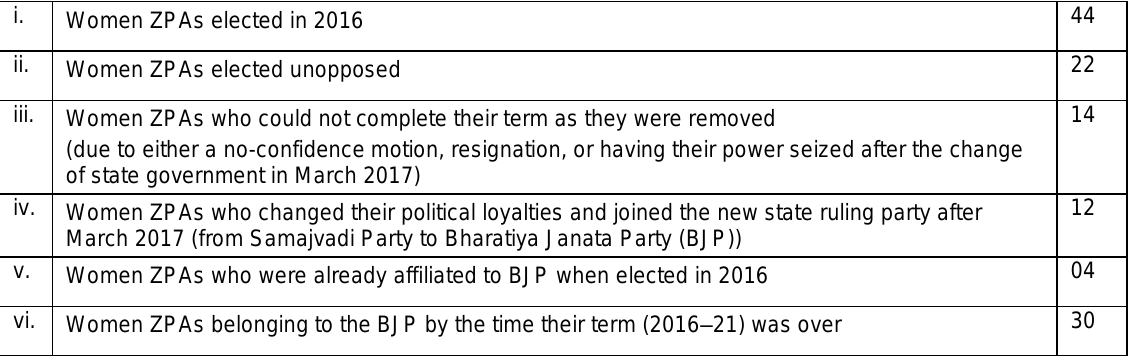
Table 1: Effect of change of ruling party on women ZPAs’ term of office and affiliation